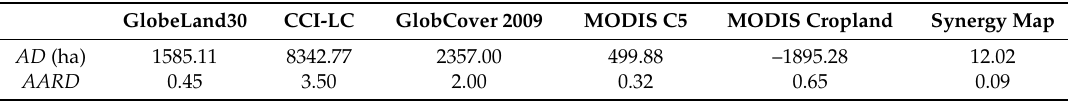
Table 5. Comparison of AD and AARD values between cropland areas from statistics and estimated by the five datasets and synergy map.